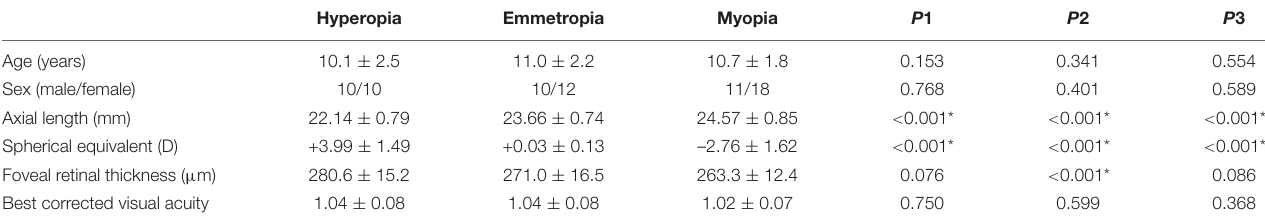
FIGURE 2 | The diagram of the parafoveal area. TABLE 1 | Study subject